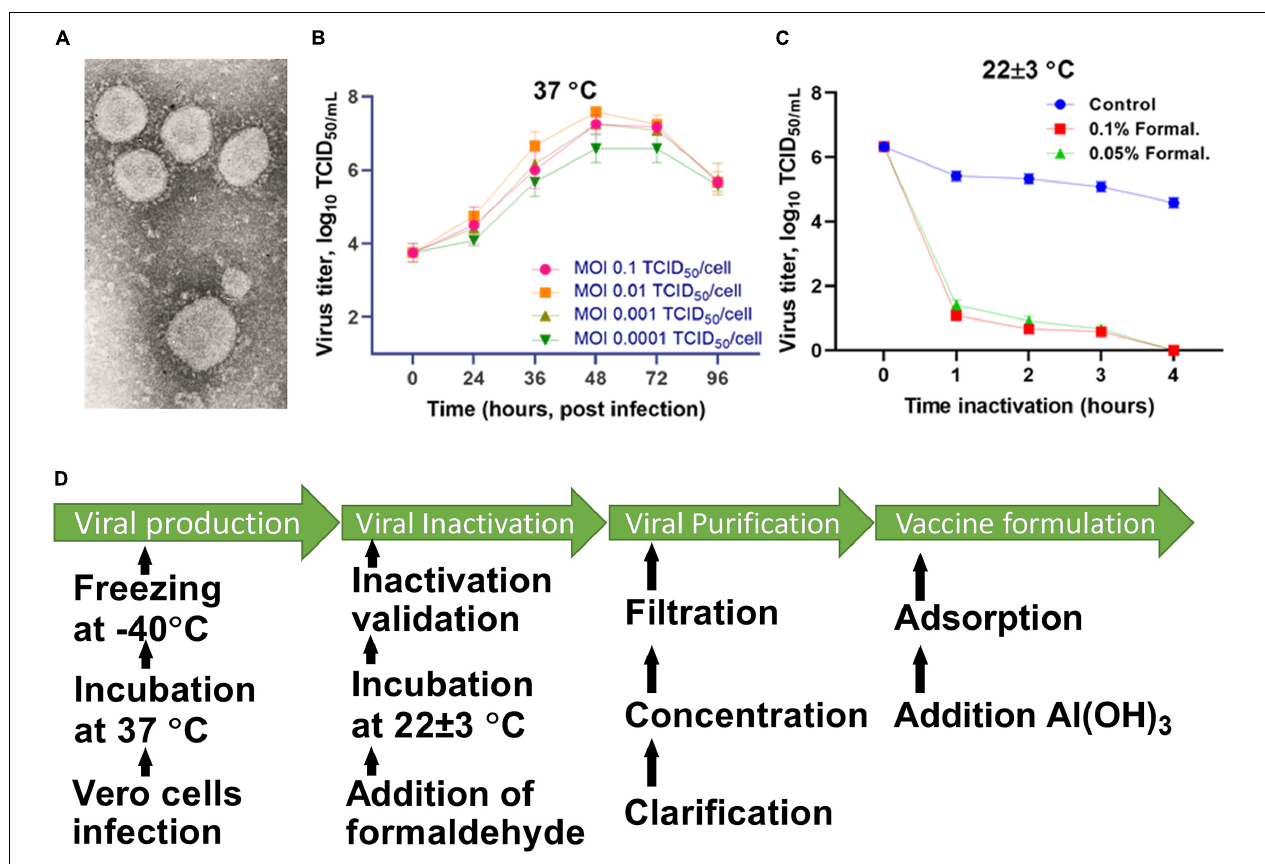
FIGURE 1 | Scheme for preparing the candidate vaccine QazCovid-in. (A) Electronic micrograph of the SARS-CoV-2 virus (magnified by × 18,000, scale bar represents 100 nm). (B) The accumulation of the virus in Vero cells, depending on the multiplicity of the infecting dose (MOI). (C) The inactivation of the virus at 25 ◦ C. (D) The preparation steps for the QazCovid-in